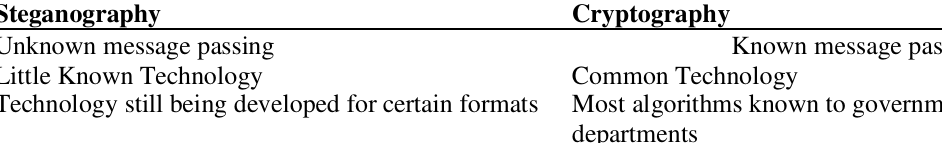
Advantages and disadvantages comparison